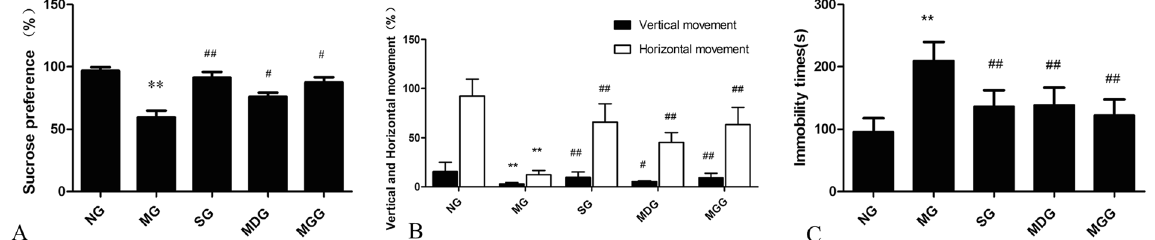
Figure 1. Effects of meloxicam on the changes in depressive-like behaviours in CUMS rats. ( A ) The sucrose preference (%); ( B ) The vertical and horizontal movements (%); ( C ) The immobility time(s); NG: normal group; MG: CUMS group; SG: Sertraline group; MDG: Meloxicam (1 mg.kg − 1 ) group; MGG: Meloxicam (3 mg.kg − 1 ). Group data shows the changes in the behaviour in rats. Data are expressed as the mean ± SD in six separate experiments. Compared with those in the normal group, the sucrose preference and the vertical and horizontal movements of rats in the open-field test were decreased, but the immobility time was increased in the CUMS group. Compared with those in the model group, the administration of sertraline and meloxicam significantly improved the sucrose preference, increased the horizontal and vertical scores and decreased the immobility time in the forced swimming test of depressive rats. ** P < 0.01 vs the normal group. # P < 0.05 and ## P < 0.01 vs the CUMS group,